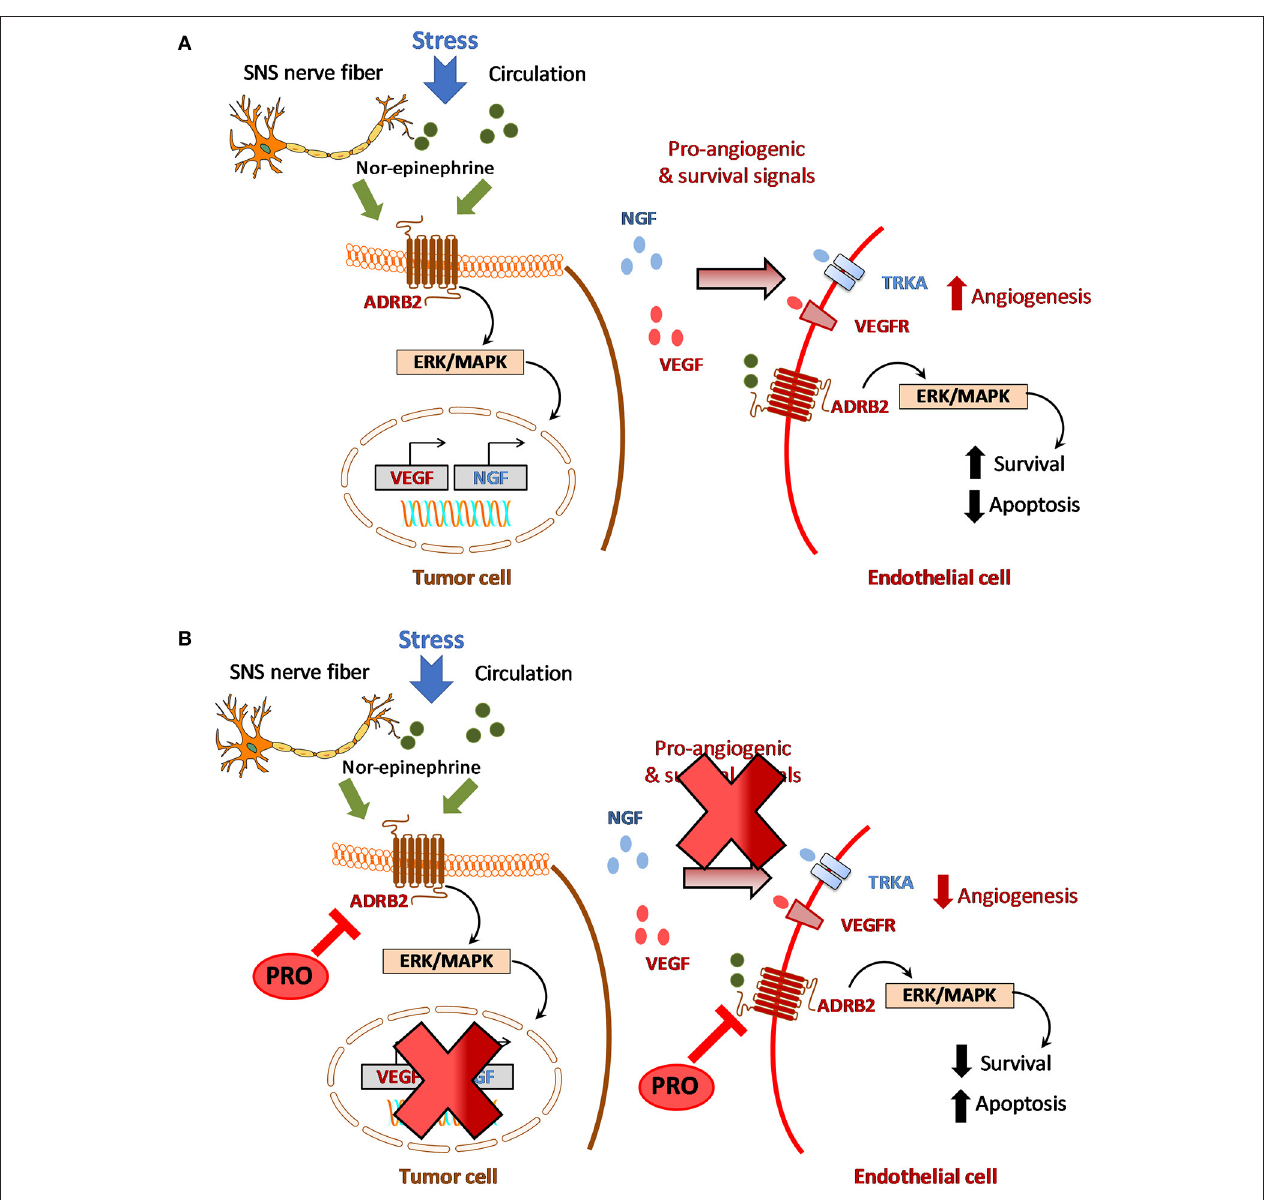
FIGURE 1 | Crosstalk between adrenergic signaling and angiogenesis in HNSCC. (A) Stress induced activation of beta-adrenergic signaling within the tumor microenvironment which in turn promotes angiogenesis and disease progression. (B) Hypothetical model for targeting adrenergic-angiogenic axis in HNSCC using